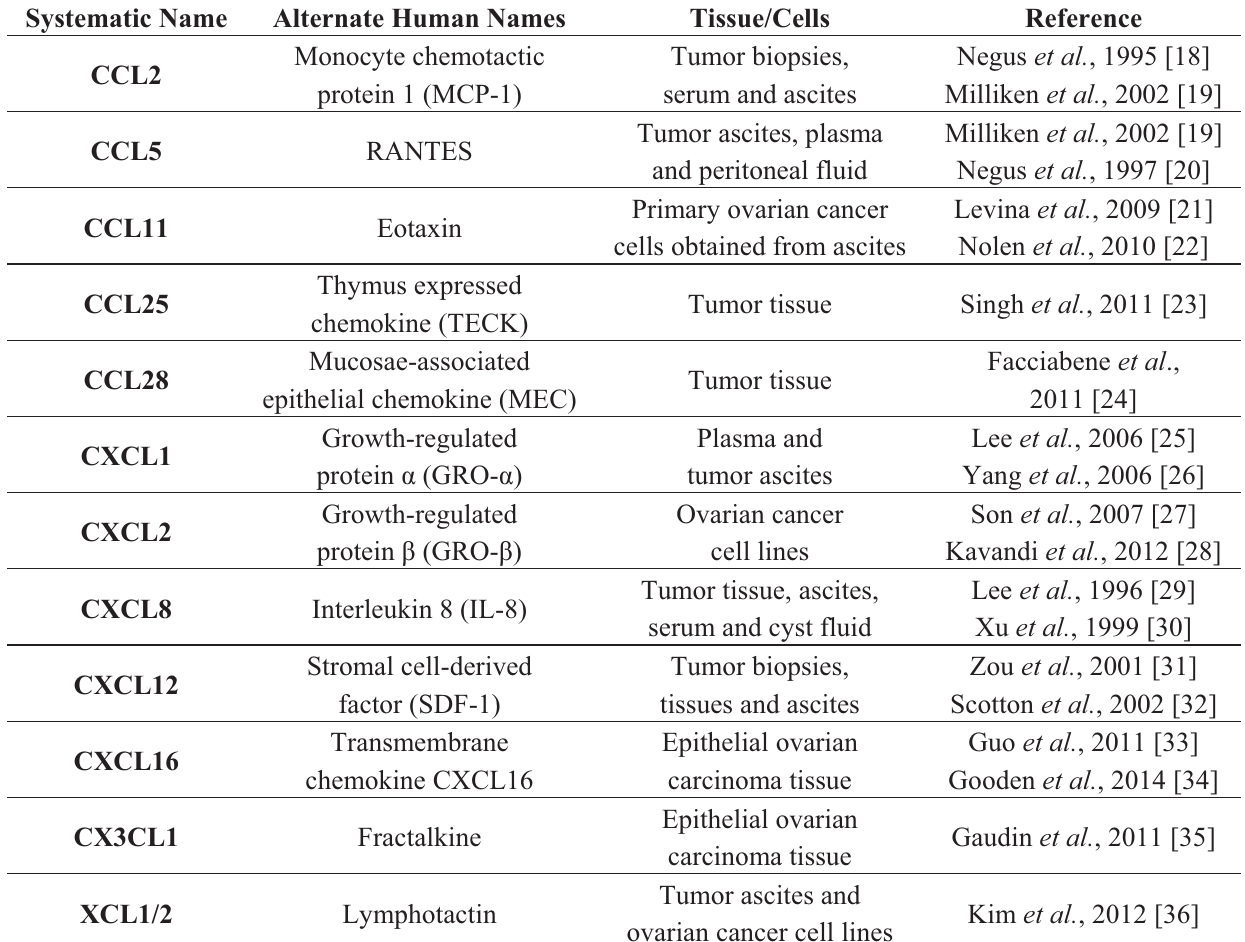
Table 1. Chemokines released by ovarian cancer